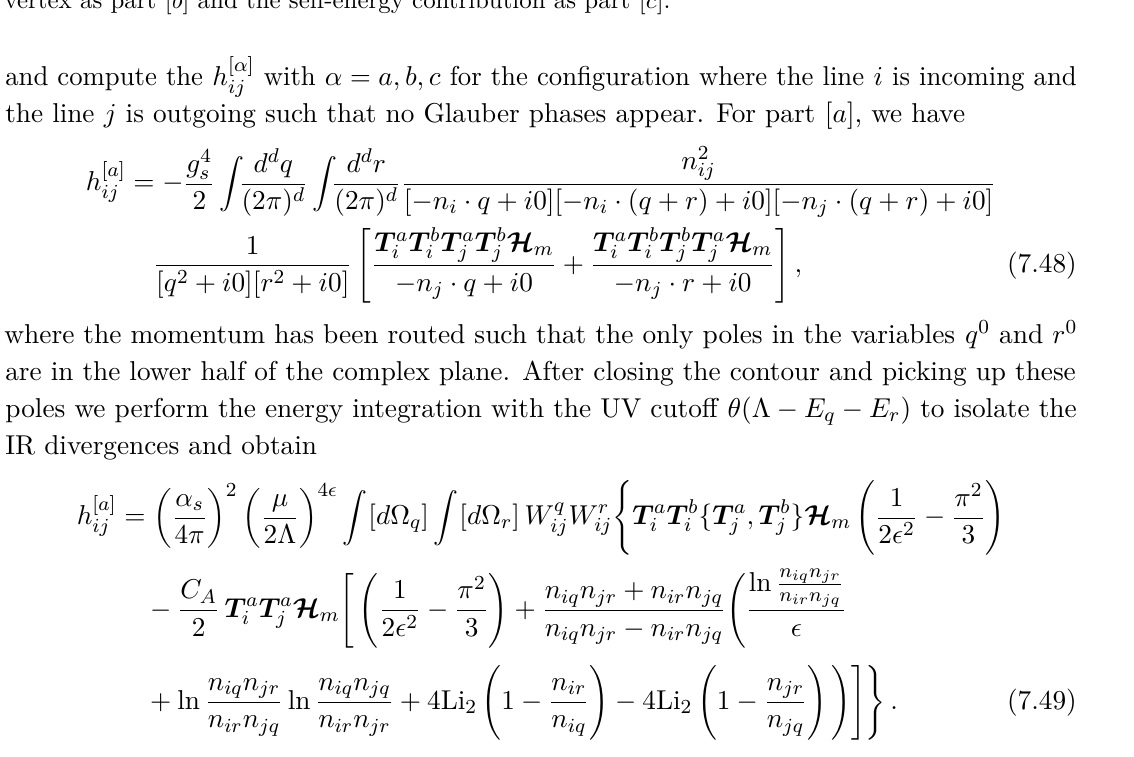
Figure 2 . Double-virtual diagrams involving two eikonal lines i and j . We denote the contribution from the two Abelian diagrams as part [ a ]) , the contribution from the diagram with a three-gluon vertex as part [ b ] and the self-energy contribution as part [ c ]